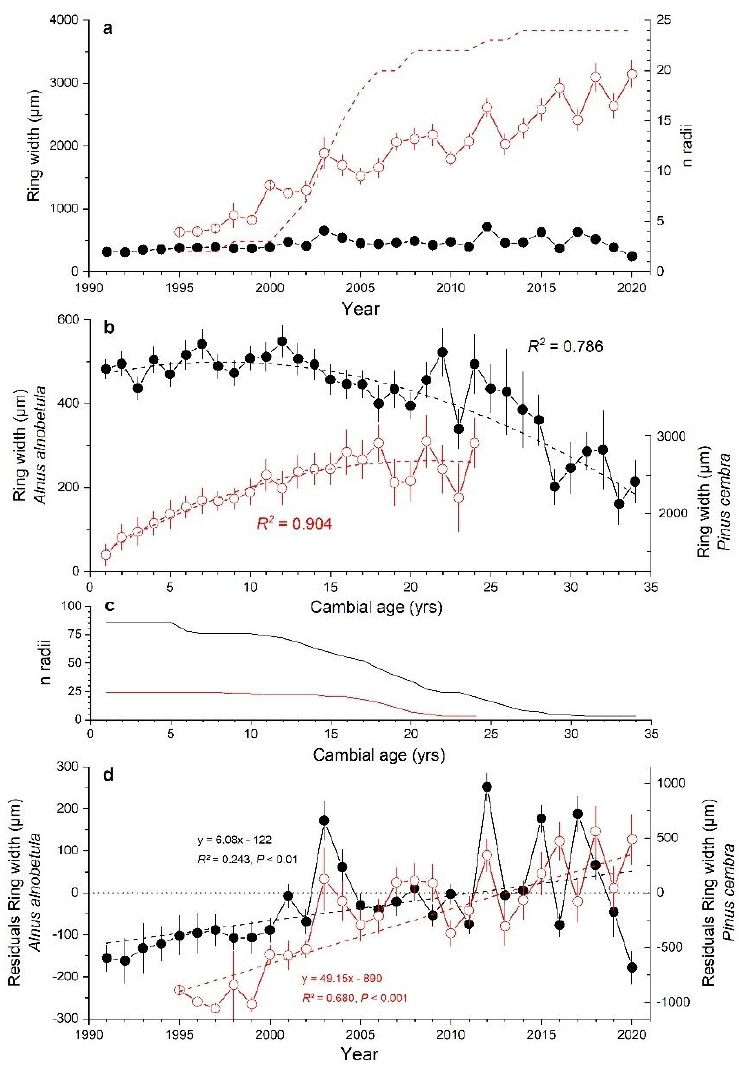
(Figure 5a–d): (i) mean ring width of P. cembra (2311 ± 628 µ m; mean sensitivity 24%) was more than four-times larger than that of A. alnobetula (Figures 2a and 5a), (ii) P. cembra showed markedly increasing growth rates with age/size while A. alnobetula stems showed only slightly increasing growth during the first decade which steadily declined thereafter (Figure 5b), (iii) the long-term trend in ring widths after eliminating age/size trend was more pronounced in P. cembra than in A. alnobetula (Figure 5d), and (iv) up to 2015 there was some synchrony in the ring width time series between A. alnobetula and P. cembra which is lost thereafter (Figure 5d). The different growth response to environmental conditions prevailing in 2016 and continuously decreasing RG in A. alnobetula since 2017 stand out in particular.